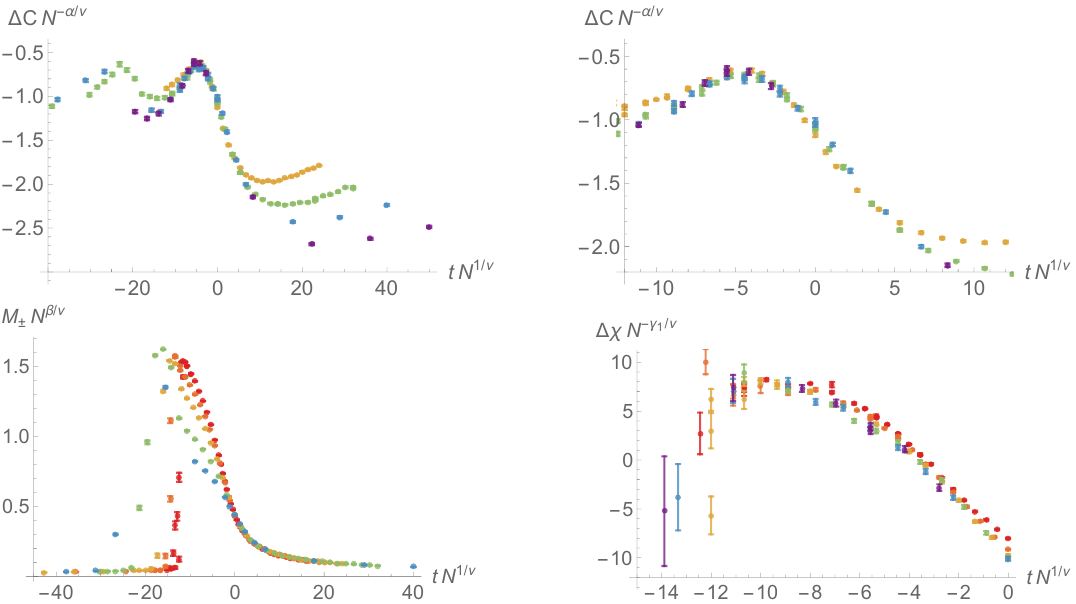
Figure 10 . Collapsed diagrams for l→↑↓ transition at c 4 = 1 . Critical exponents are ν = 1 . 00(15) , e α = − 0 . 41(6) , β = 0 . 42(2) and γ = − 0 . 99(7) . ∆ C = C − 0 . 84(6) = − 0 . 67(14) · N α/ν and γ 1 is the exponent of the correction to the scaling behaviour of susceptibility ∆ χ = χ − 1 . 13(2) · N γ/ν = 7 . 5(4) · N − 2 . 00(6) . Different colors represent different matrix sizes up to N = 50 .